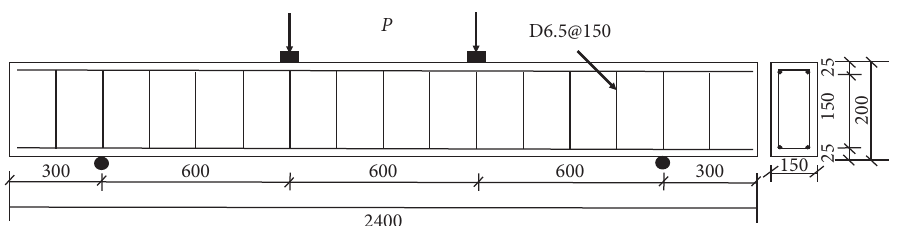
Figure 3: Details of longitudinal reinforcement (all dimensions in mm).